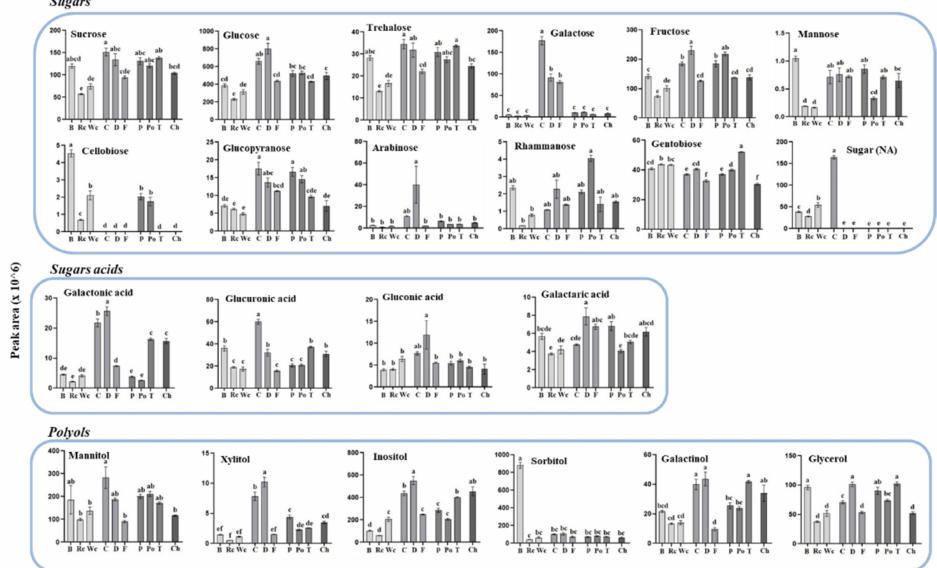
Figure 5. The levels of individual primary metabolites of sugars, sugar acids and polyols of P. aegyptiaca grown on 10 host plants as detected by using GC-MS. Values are relative peak areas normalized to the norleucine internal standard. The Y axis represents the area of relative m/z response of each metabolite following normalization to the norleucine internal standard and the X axis represents the host plants designated as Broccoli (B), Red cabbage (Rc), White cabbage (Wc), Carrot (C), Dill plant (D), Fennel bulbs (F), Pepper (P), Potato (Po), Tomato (T) and Chickpea (Ch). Data shown are means ± SE of four replicates for each plant type. Significance is calculated according to the Turkey Kramer HSD test ( p < 0.05) and is denoted by different small letters. NA—non-annotated